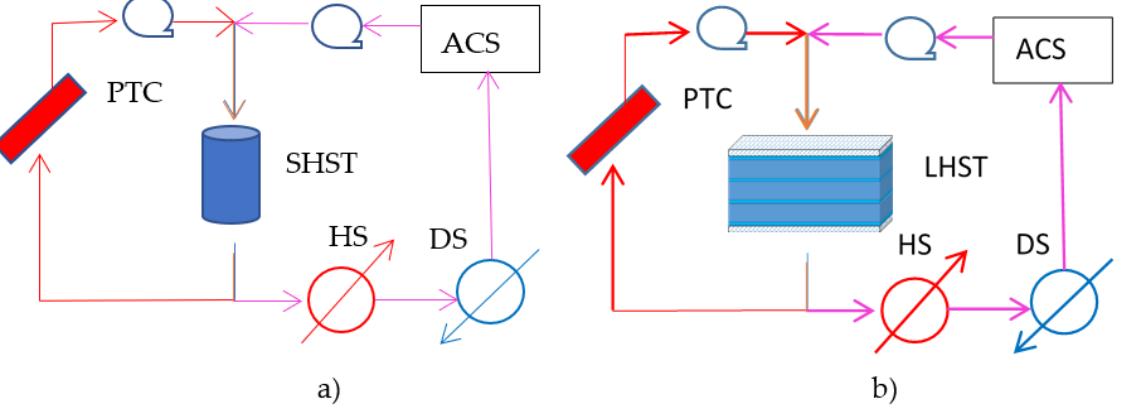
Figure 5. Solar cooling system with ( a ) sensible heat and ( b ) latent heat storage tank.